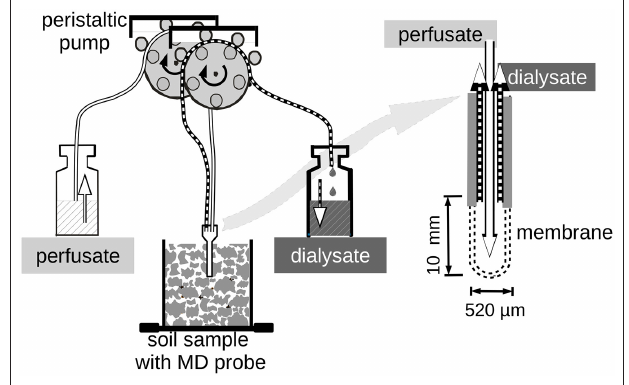
FIGURE 1 | Overview of the microdialysis (MD)